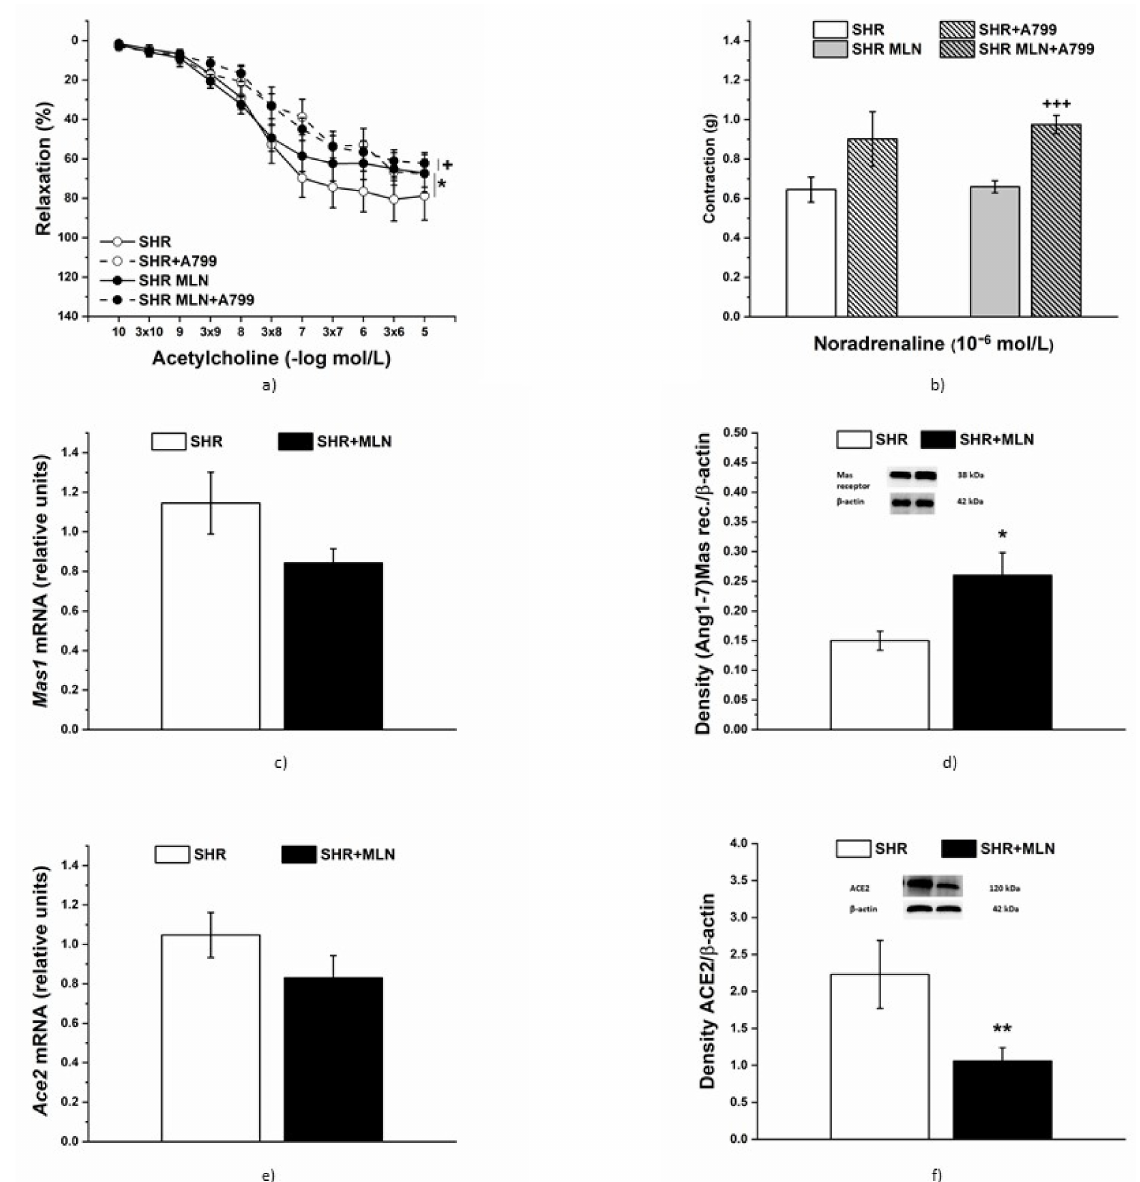
Figure 5. The effect of acute Mas receptor inhibition on the endothelium-dependent vasorelaxation ( a ) and contractile response ( b ) of TA isolated from control SHRs and SHRs treated with MLN-4760. The mRNA levels of the Mas1 and ACE2 genes ( c , e ) and the protein expression of the Mas receptor and ACE2 ( d , f ) were measured in aortic tissue. The results are presented as the mean ± S.E.M., and differences between groups were analyzed by three-way ANOVA or Student ´ s t -test, as appropriate. * p < 0.05 vs. SHRs, ** p < 0.01 vs. SHRs; + p < 0.05, +++ p < 0.001 vs. SHR +